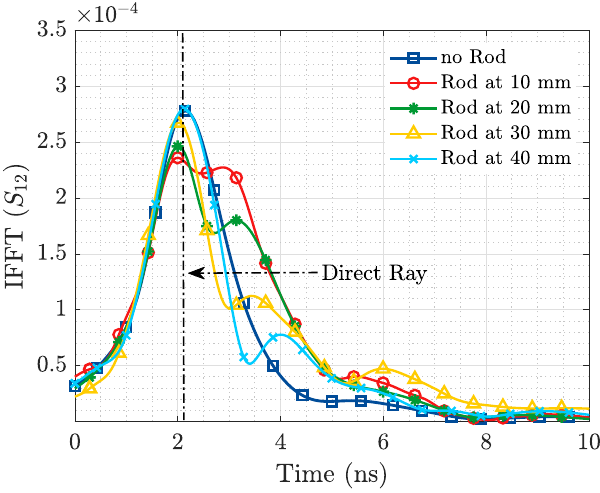
Figure 8. Metallic Rod Detection. Simulation IFFT.